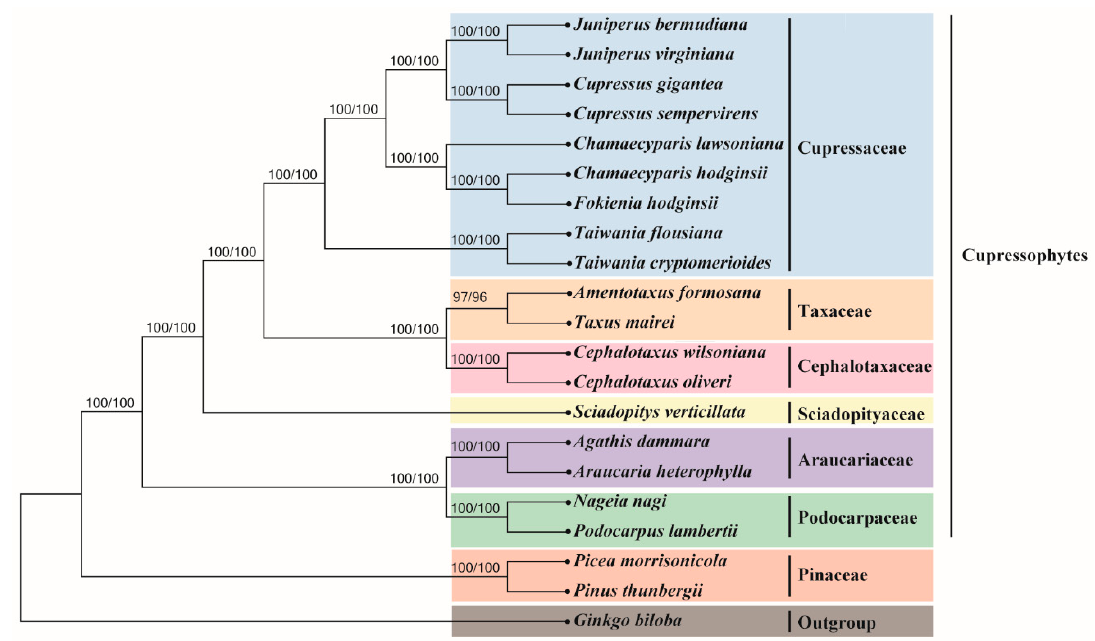
Figure 7. The maximum likelihood (ML) and neighbor-joining (NJ) phylogenetic tree based on 63 eligible genes from 21 species. Numbers above the nodes are bootstrap values. G. biloba was set as the outgroup.